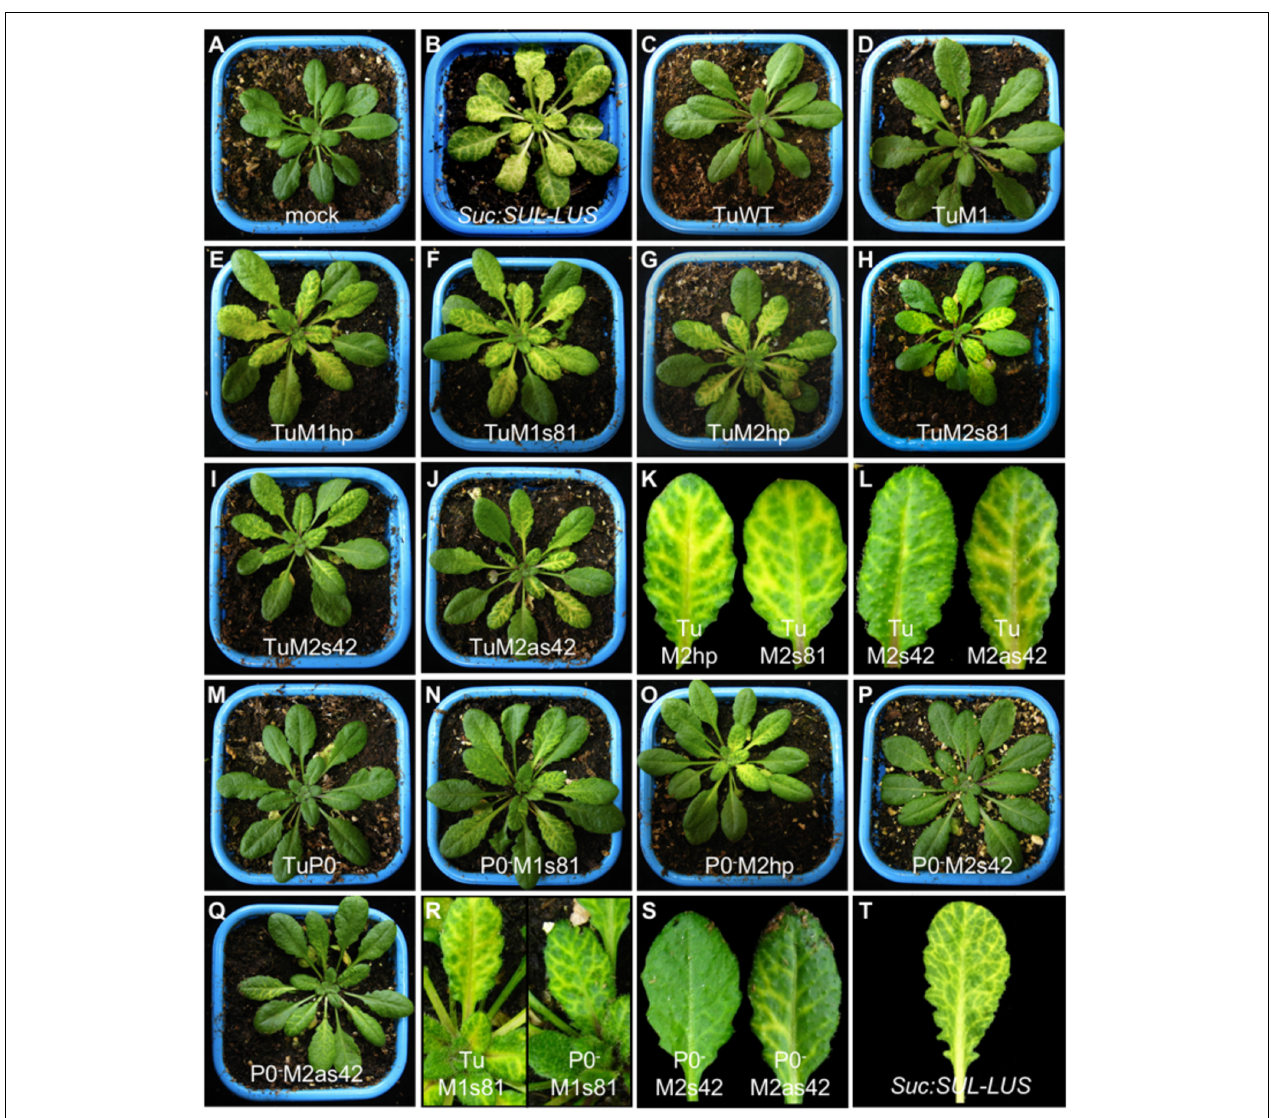
FIGURE 3 | Phenotypic analysis of A. thaliana Col-0 plants agroinfected with mutant or recombinant TuYV in either wild-type (panels C–L ) or P0-deficient mutant virus (P0 - ) background (panels M–S ). The recombinant viruses are noted in each panel. Pictures were taken 18 days post-inoculation. (A) mock-inoculated plant, (B) transgenic non-infected Suc:SUL-LUS plant (Himber et al., 2003). Plants infected with TuM2 (not shown) were asymptomatic as were plants infected with TuWT and TuM1 ( C and D ). Closer views of individual leaves are shown for plants infected with some mutants ( R and S ) and the transgenic Suc:SUL-LUS plant (T) .